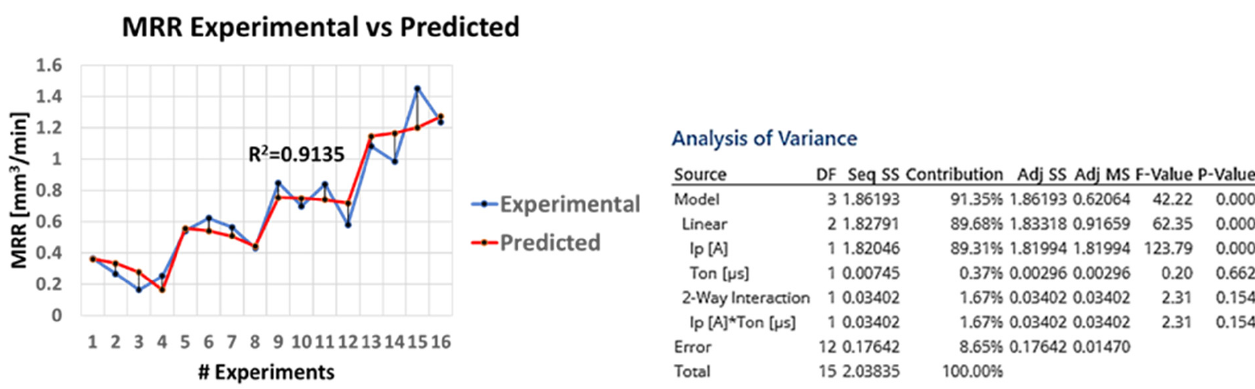
Figure 4. Plot of experimental MRR vs predicted MRR along with model’s ANOVA .